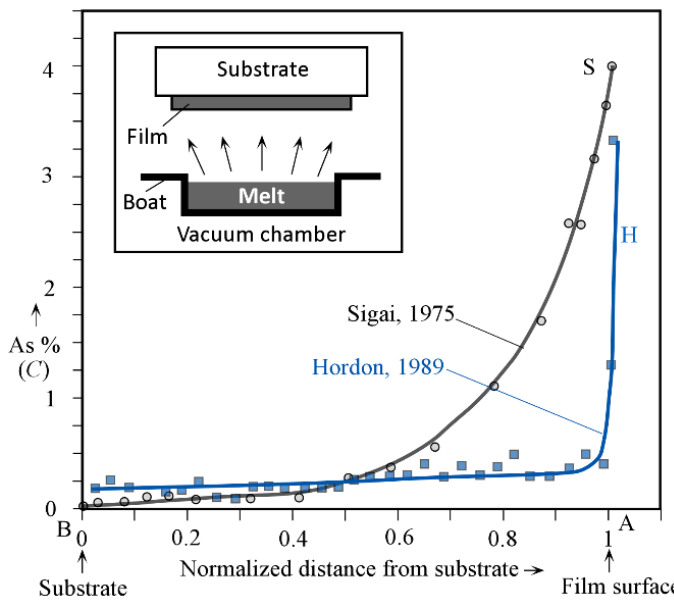
Figure 1. As concentration (%) as a function of normalized thickness x / L across the film thickness of two evaporated a ‐ Se films. Data have been extracted, normalized, combined, and replotted from Sigai 1975 [4] (sample S), and Hordon 1989 [5] (sample H). The As content in the source material is 0.50% for S and 0.34% for H. Both films were approximately 60 μ m in thickness. (A and B correspond to the film surface and substrate respectiveley).